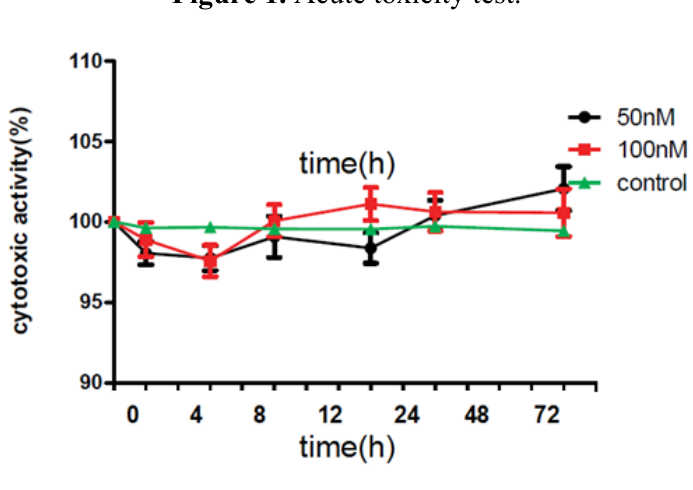
Figure 1. Acute toxicity